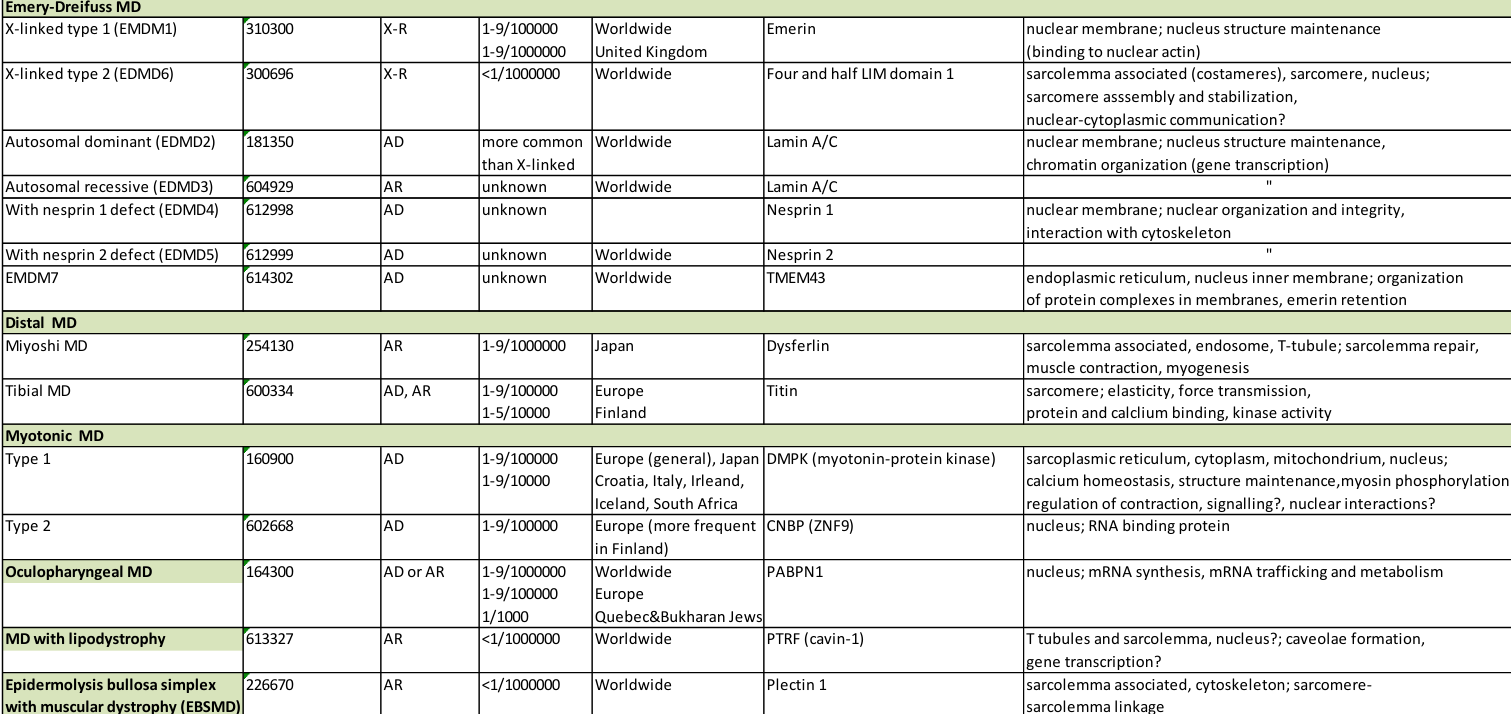
Table 1. Cont. Int. J. Mol. Sci. 2018 , 19 , x FOR PEER REVIEW 5 of